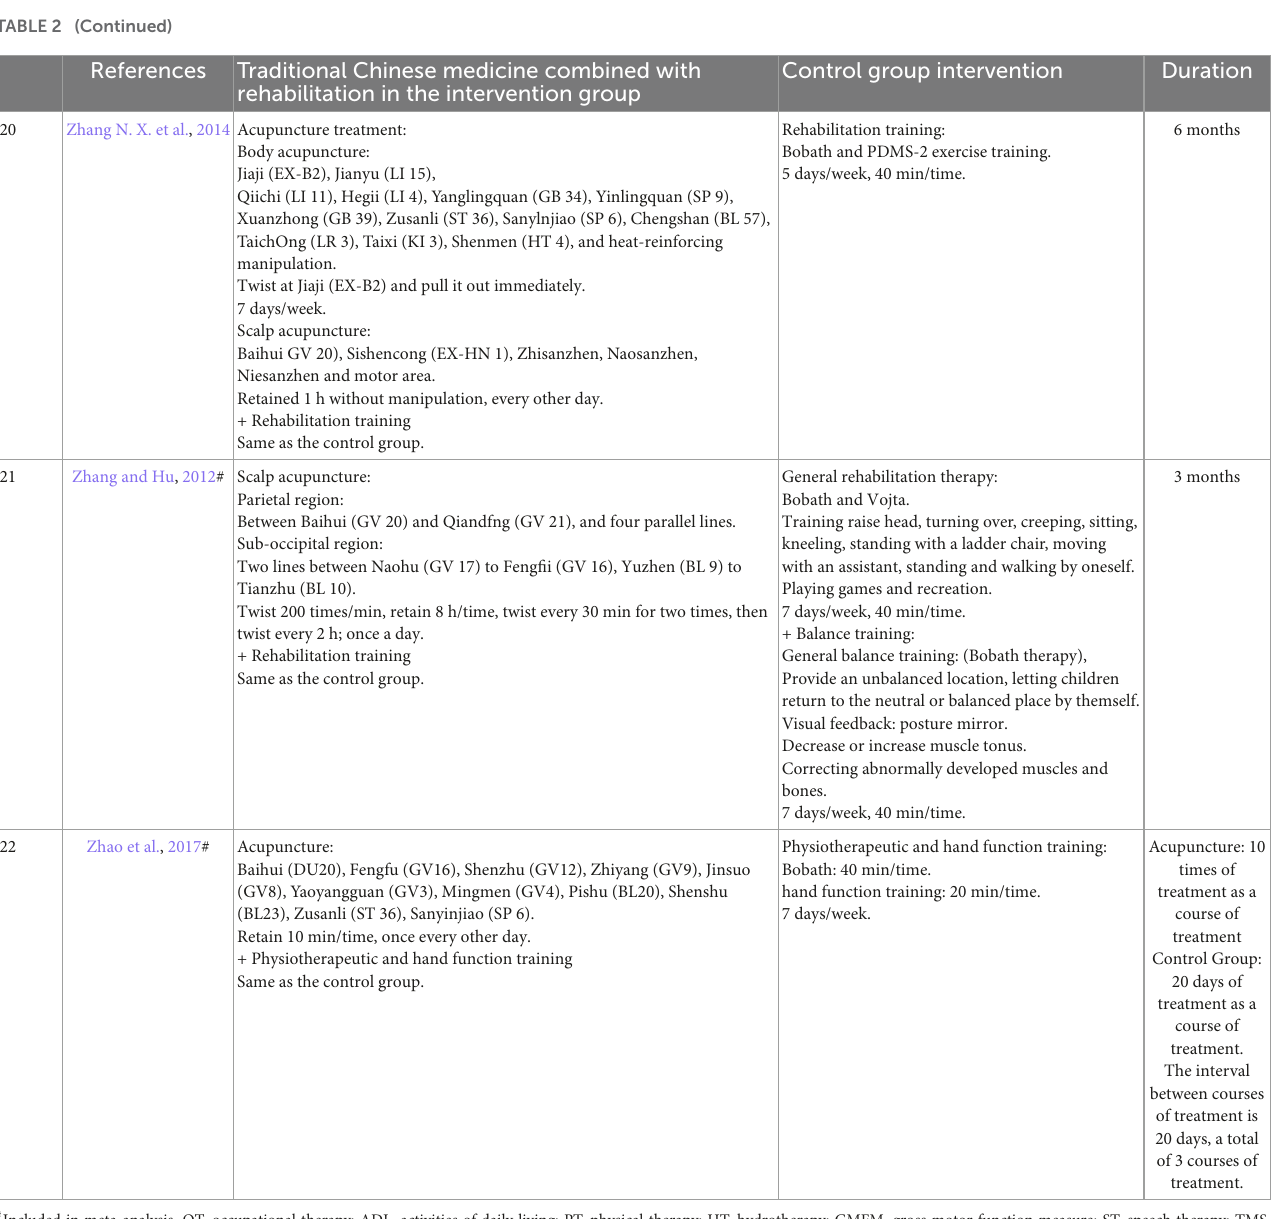
Table 1 . The intervention method, treatment frequency, and treatment duration of the intervention group and the control group are shown in Table 2